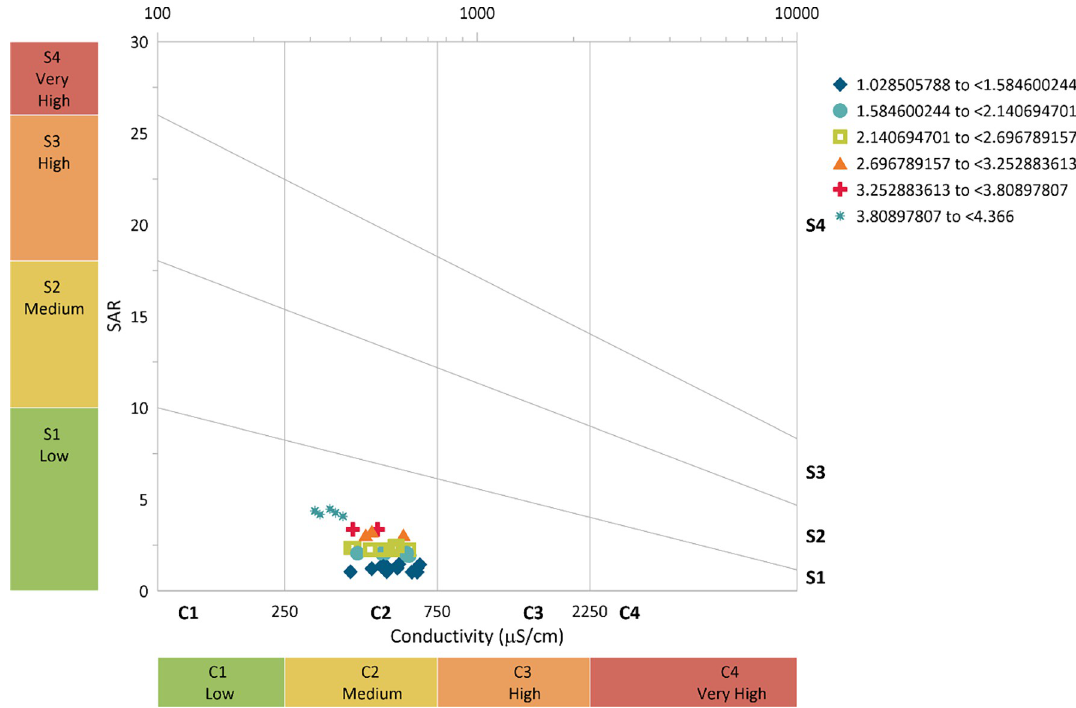
Fig 10. Salinity hazard from 0.75 m column effluent.